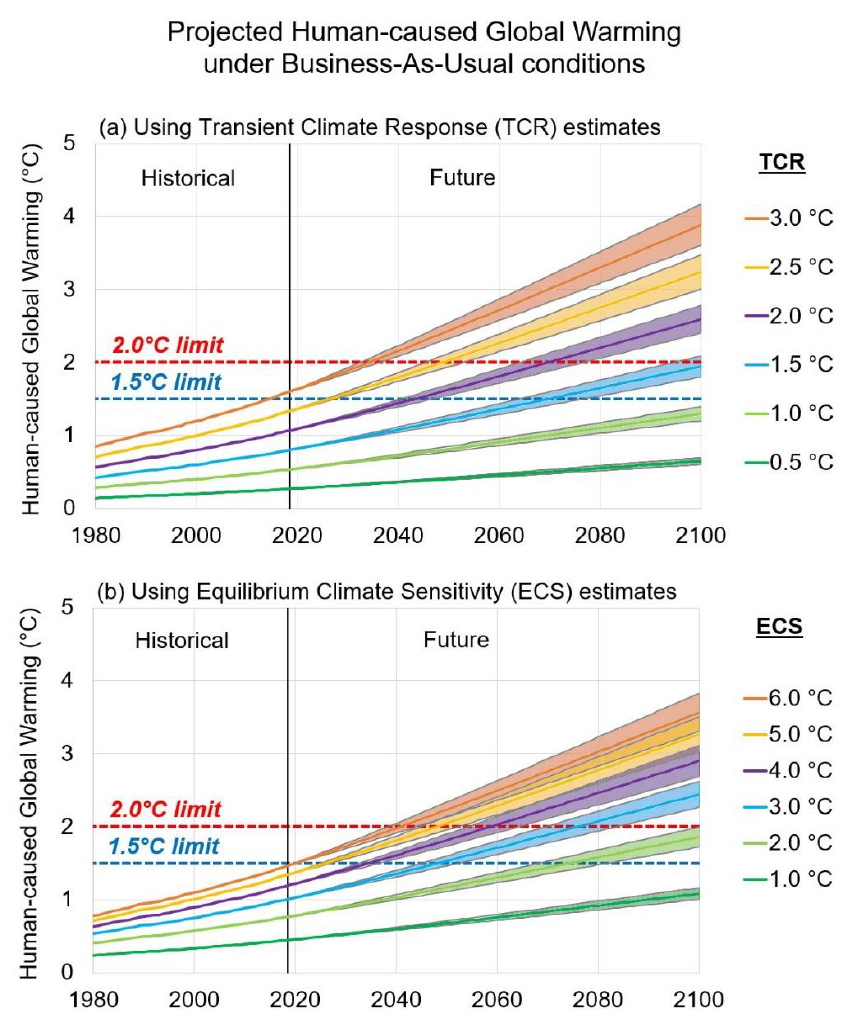
Figure 13. Projected human-caused global warming (from CO 2 , CH 4 , and N 2 O greenhouse gases) up to 2100 under Business-As-Usual conditions for various estimates of ( a ) the Transient Climate Response and ( b ) Equilibrium Climate Sensitivity. For comparison, the 2.0 and 1.5 °C targets described under the Paris Agreement (2015) [19] are shown. The horizontal axes correspond to years.